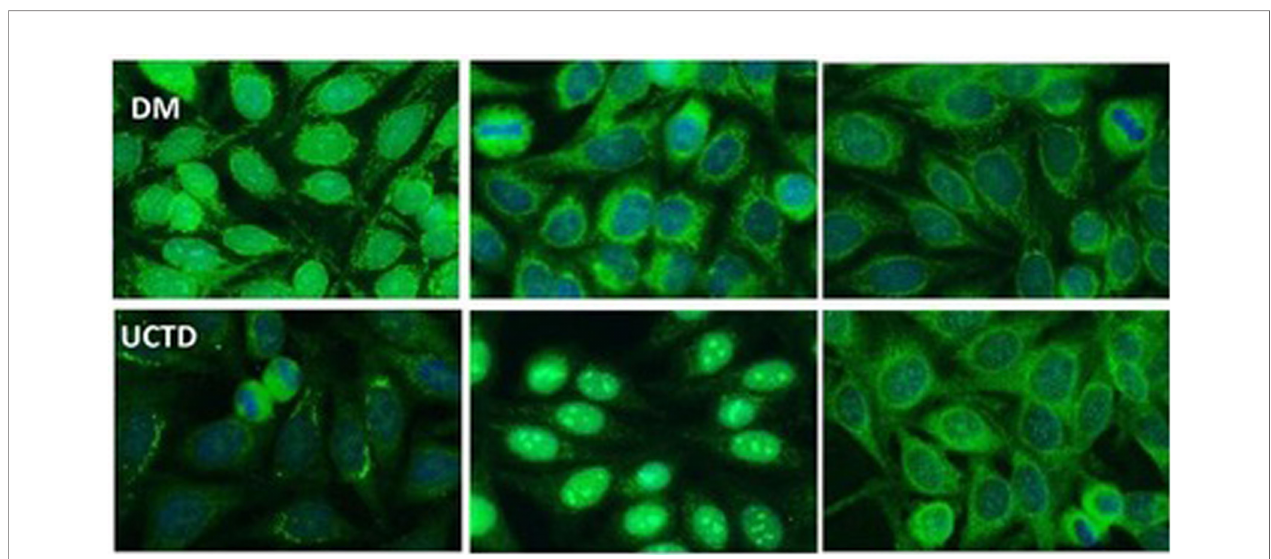
FIGURE 3 | Representative cytoplasmic reticular patterns observed by IIF HEp-2 in AMA-positive patients. In the DM row, we show IIF on HEp2 cells of a DM patient with cytoplasmic staining pattern limited around the nuclei, not spread in the whole cytoplasm as in the case of cytoplasmic reticular AMA-like typical pattern. In the UCTD row, the IIF HEp-2 pattern shows a differential distribution of reticular areas. AMA, antimitochondrial antibodies; IIF, indirect immuno fl uorescence; DM, dermatomyositis; UCTD, undifferentiated connective tissue